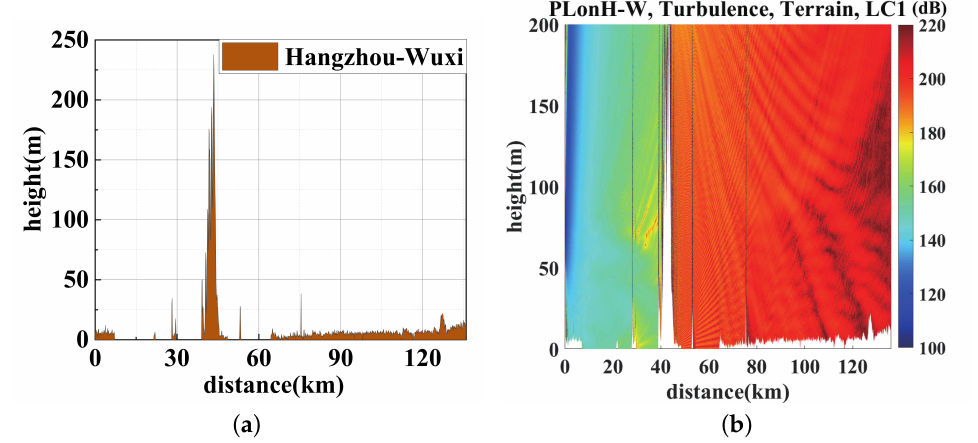
Figure 13. The ( a ) DEM and ( b ) propagation loss with tropospheric scattering, IGBP LC, and DEM considered on Hangzhou–Wuxi. ( a ) DEM form Hangzhou to Wuxi. ( b ) Propagation loss on Hangzhou–Wuxi.